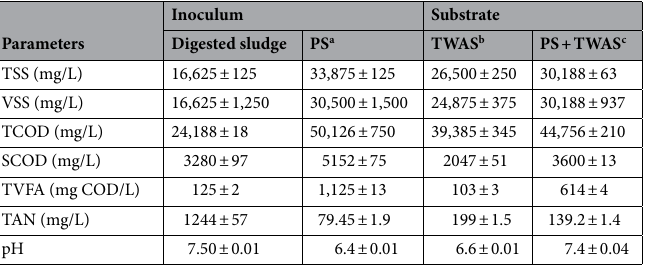
Table 1. Characteristics of substrates and inoculum. a Primary sludge (PS). b Thickened waste activated sludge (TWAS). c Mixture of PS and TWAS (volume ratio of